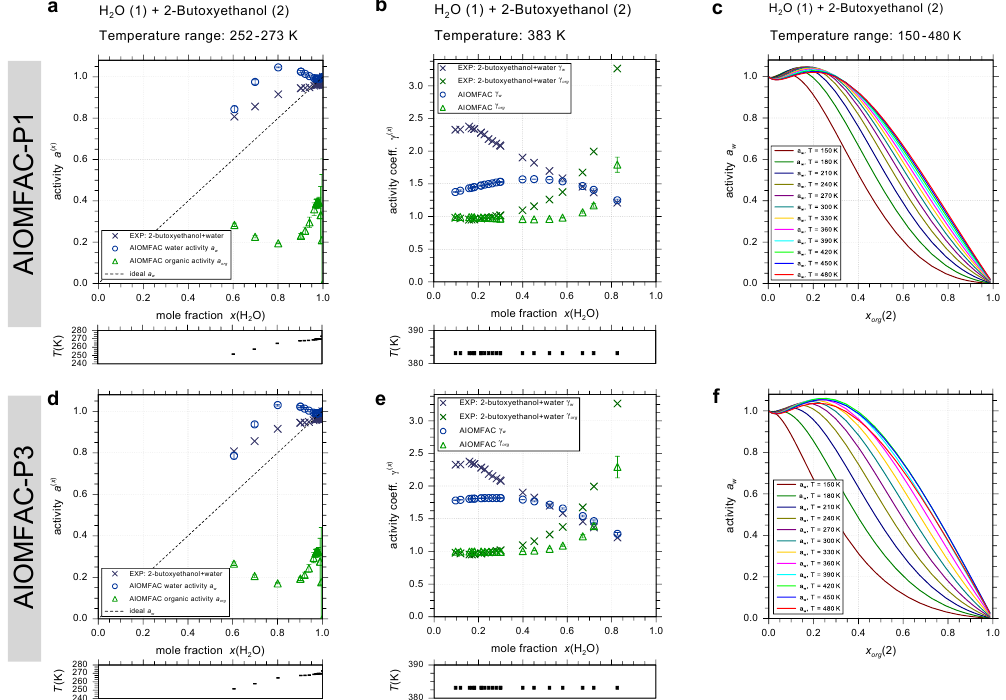
Figure 6. SLE and VLE measurements for 2-butoxyethanol + water solutions and corresponding calculations of AIOMFAC-P1 (a–c) or AIOMFAC-P3 (d–f) . Panels (c, f) show the temperature dependence of water activities predicted for the range 150–480K. (a, d) Low temperature experimental SLE data (crosses) are compared with the predictions for water activity at the same compositions and temperatures (blue circles). Predictions of the corresponding organic activities are shown as well (green triangles). The error bars represent the model sensitivity to a composition variation by x tol = 0 . 01. The dashed line represents the hypothetical water activity of an ideal mixture. Panels (b, e) show the model predictions of the activity coefficients compared to VLE data covering temperatures significantly higher than room temperature. The temperatures of the individual data points are given in the boxes below the main panels. Experimental data: Koga et al. (1994) and Schneider and Wilhelm